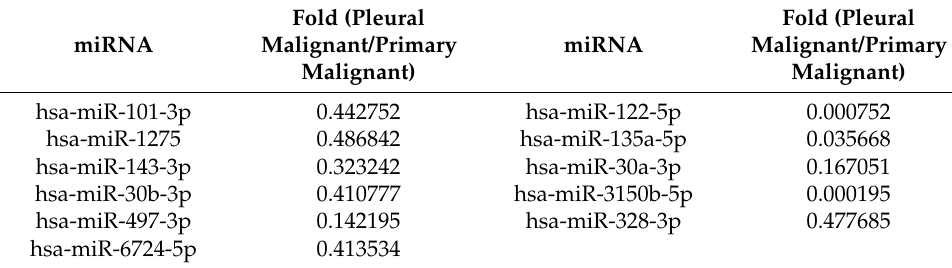
Figure 3. The effect of UBE2H silencing on the cell migratory capacity in LUAD cell lines. ( A ) The effect of UBE2H shRNA is examined in A549. ( B ) Wound-healing assay ( n = 3). ( C ) Transwell migration assay and quantitative results ( n = 3). ( D ) Western blot assay for determining the regulatory molecules of the epithelial–mesenchymal transition signaling pathway ( n = 3). * p -value < 0.05, as compared with the vector control. Table 2. The candidate miRNAs regulating